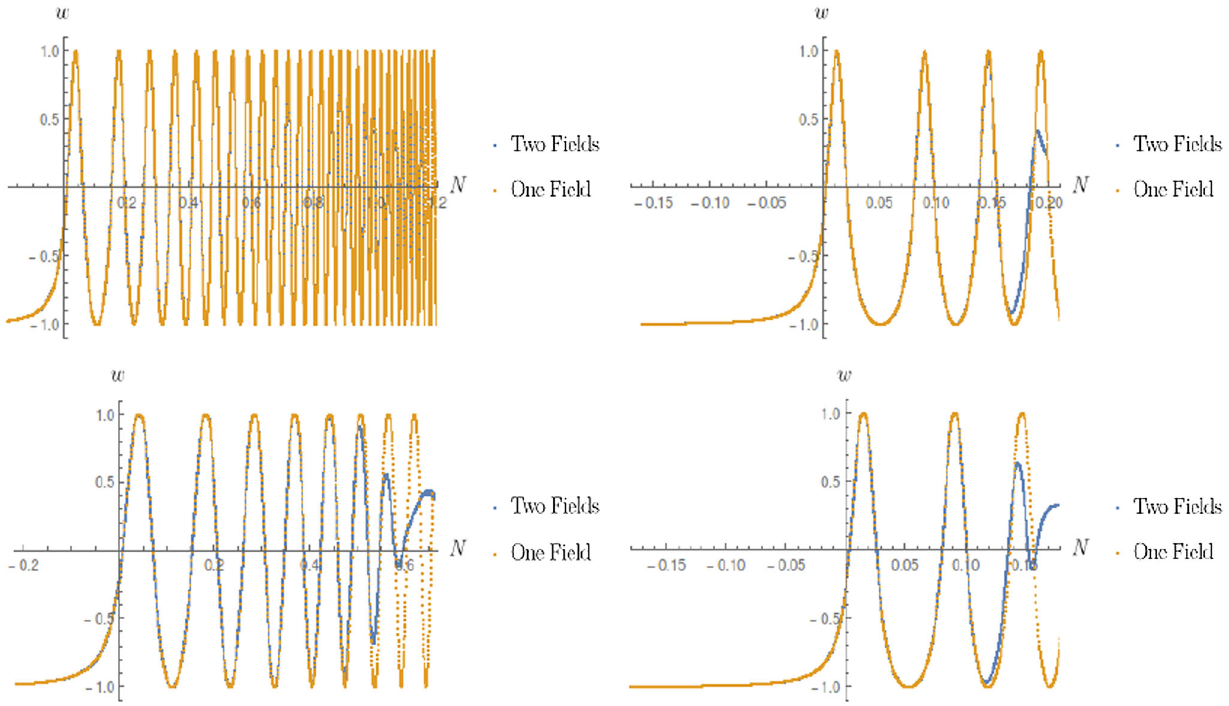
Fig. 6 The evolution of the barotropic parameter w (not averaged) for n = 1 , α = 10 − 3 (upper left), n = 1 , α = 10 − 4 (upper right), n = 1 . 5 , α = 10 − 3 (lower left), n = 1 . 5 , α = 10 − 4 (lower right). N